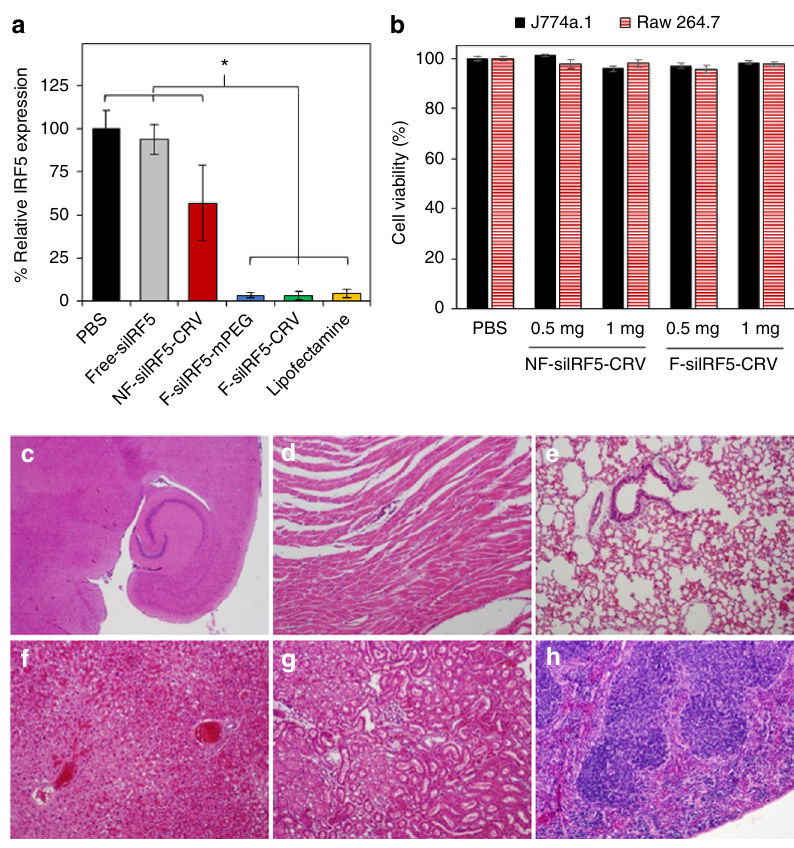
Fig. 3 Gene knockdown in vitro and in vivo cytotoxicity of fusogenic porous Si nanoparticle constructs. a siRNA knockdown results (via qRT-PCR) from Raw 264.7 macrophage cells incubated with nanoparticles for 24 h. Error bars indicate SD ( n = 6). The fusogenic formulations show substantial knockdown, comparable to standard lipofectamine transfection agent. No signi fi cant difference in knockdown ef fi ciency is observed between the two fusogenic formulations (F-siIRF5-mPEG, F-siIRF5-CRV) and lipofectamine. *Signi fi cant difference (one-way ANOVA with Tukey ’ s HSD post hoc test, p -level< 0.05, F (5, 30) = 28, p = 6.9 × 10 − 10 ). b Viability of J774a.1 and Raw 264.7 macrophage cells after 1 h incubation with NF-siIRF5-CRV and F-siIRF5-CRV nanoparticle constructs, containing 0.5 and 1 mg total mass of lipid as indicated. Error bar indicates SD ( n = 6). ANOVA test found no statistical signi fi cance at p < 0.01; c – h H&E staining of major organs after 24 h circulation of F-siIRF5-CRV via tail vein injection (23.2 µ mol/kg lipid, 24 µ g/kg siRNA, 0.5 mg/kg pSi) in healthy Balb/C mice; c brain; d heart; e lung; f liver; g kidney; and h